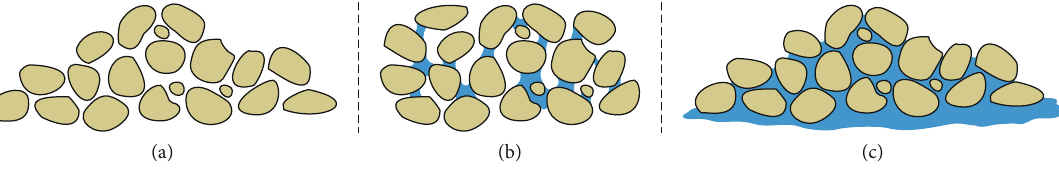
Figure 14: The interaction between sand particles and water: (a) dry sand; (b) sand with small amount of water; (c) sand immersed in